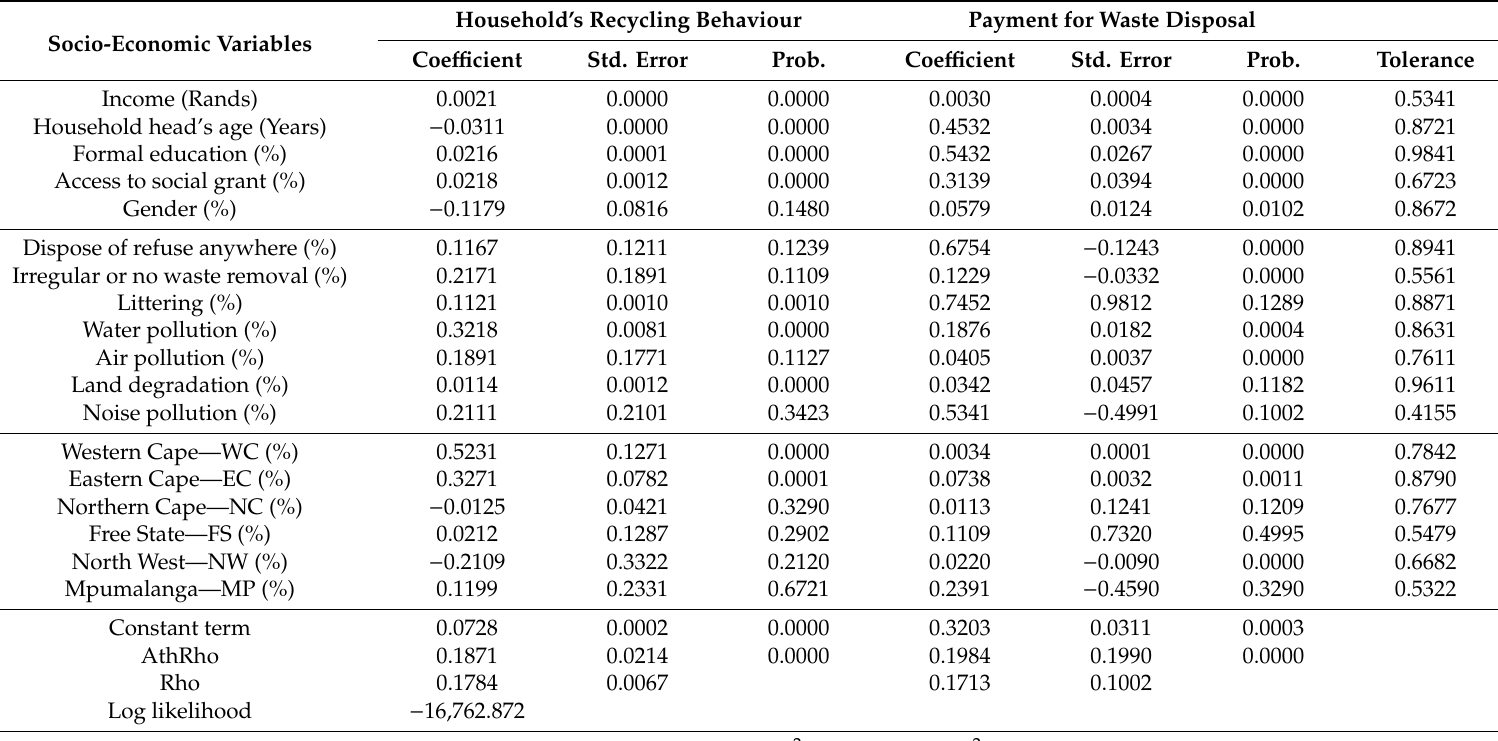
Table 6. Bivariate Probit results for factors influencing recycling and payment for waste